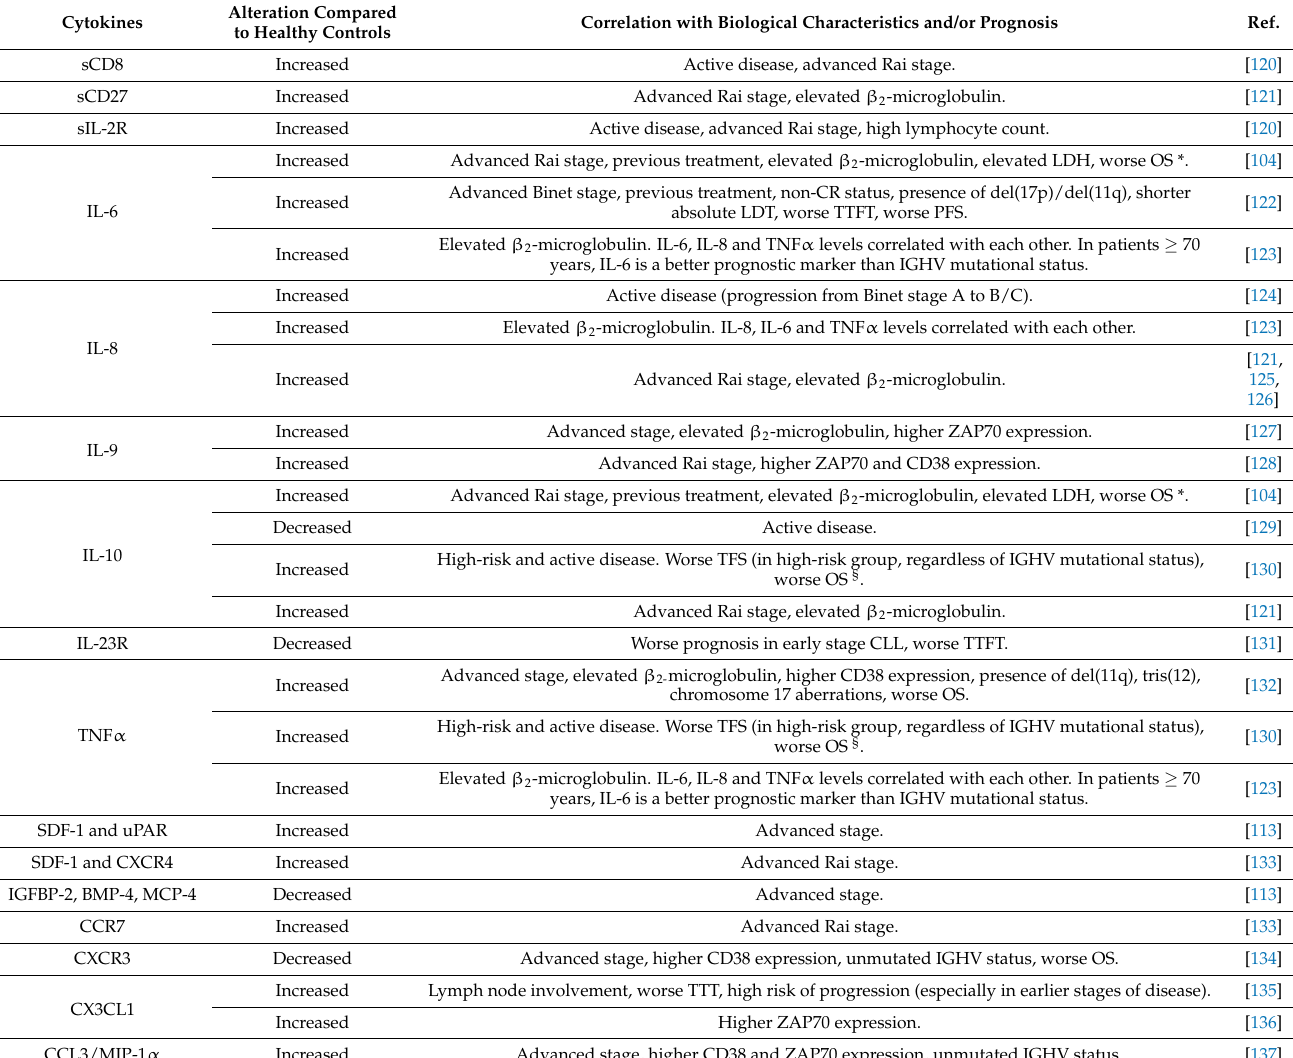
Table 2. Alterations of cytokine levels and their correlation with biological characteristics and/or prognosis in patients with CLL.